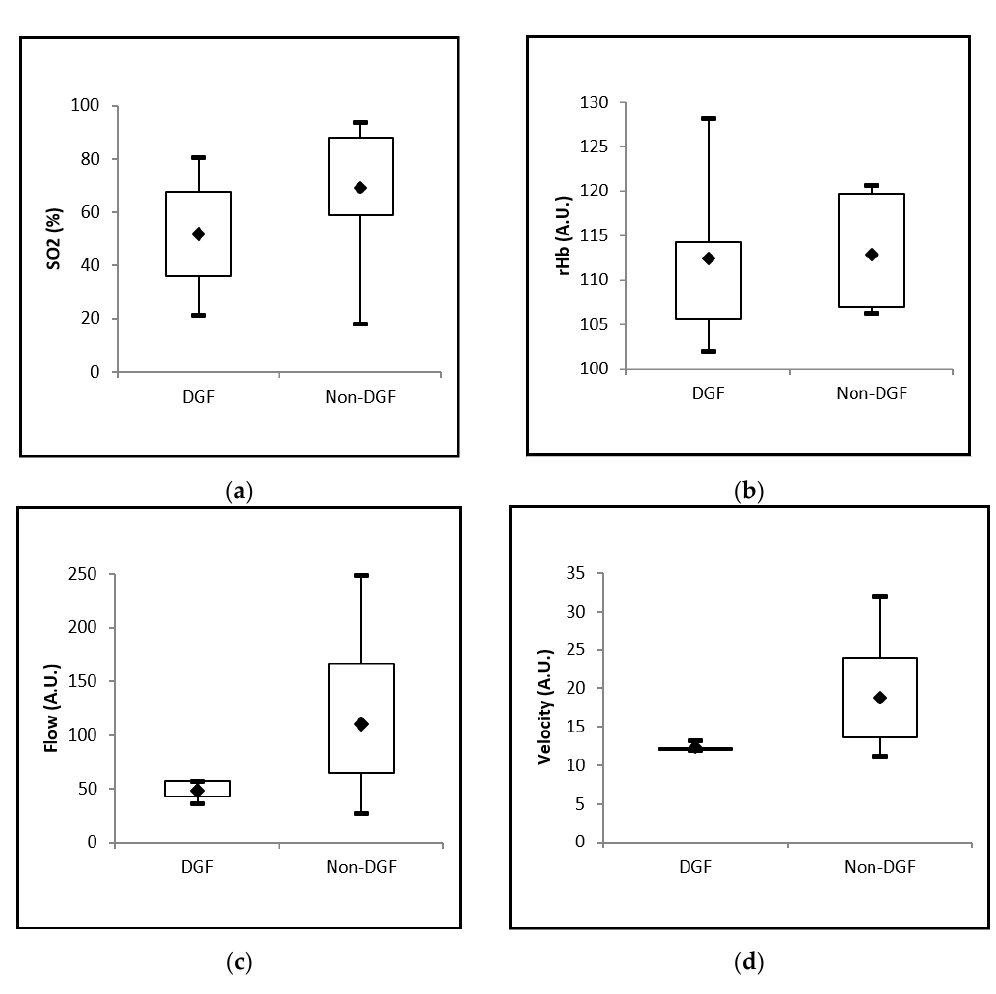
Figure 4. ( a – d ) Box plots showing intraoperative microperfusion assessment with O2C in patients with normal as opposed to delayed graft function (DGF) after kidney transplantation with significant differences for the parameters flow and velocity ( p -values: ( a ), p = 0.1700; ( b ), p = 0.5323; ( c ), p = 0.0314; ( d ), p = 0.0171). A.U., Arbitrary Units; flow, microvascular flow; rHb, relative microvascular amount of hemoglobin; SO2, postcapillary oxygen saturation of hemoglobin; velocity, microvascular blood flow velocity.